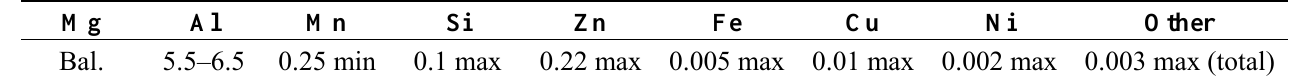
Table 1. Chemical composition of AM60B